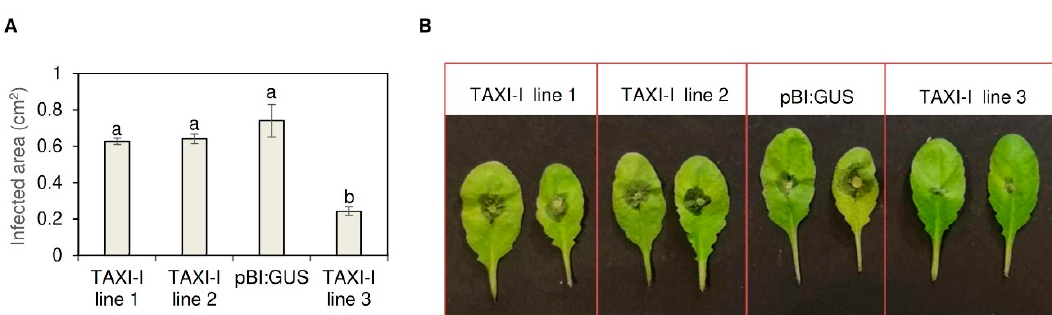
Figure 3. Histogram ( A ) and picture ( B ) showing the lesion area produced by Botrytis cinerea (strain B05.10) on Arabidopsis thaliana TAXI-I and pBI:GUS leaves at 48 h post-inoculation (hpi). Leaves were inoculated with disks (0.3 cm diameter) containing actively growing mycelium. Lesion areas are expressed in cm 2 ± standard error (SE) calculated from at least three independent infection experiments, each performed with 12 plants per line. All data were subjected to ANOVA analysis. Different letters correspond to significant differences ( P < 0.05), according to the Tukey test.